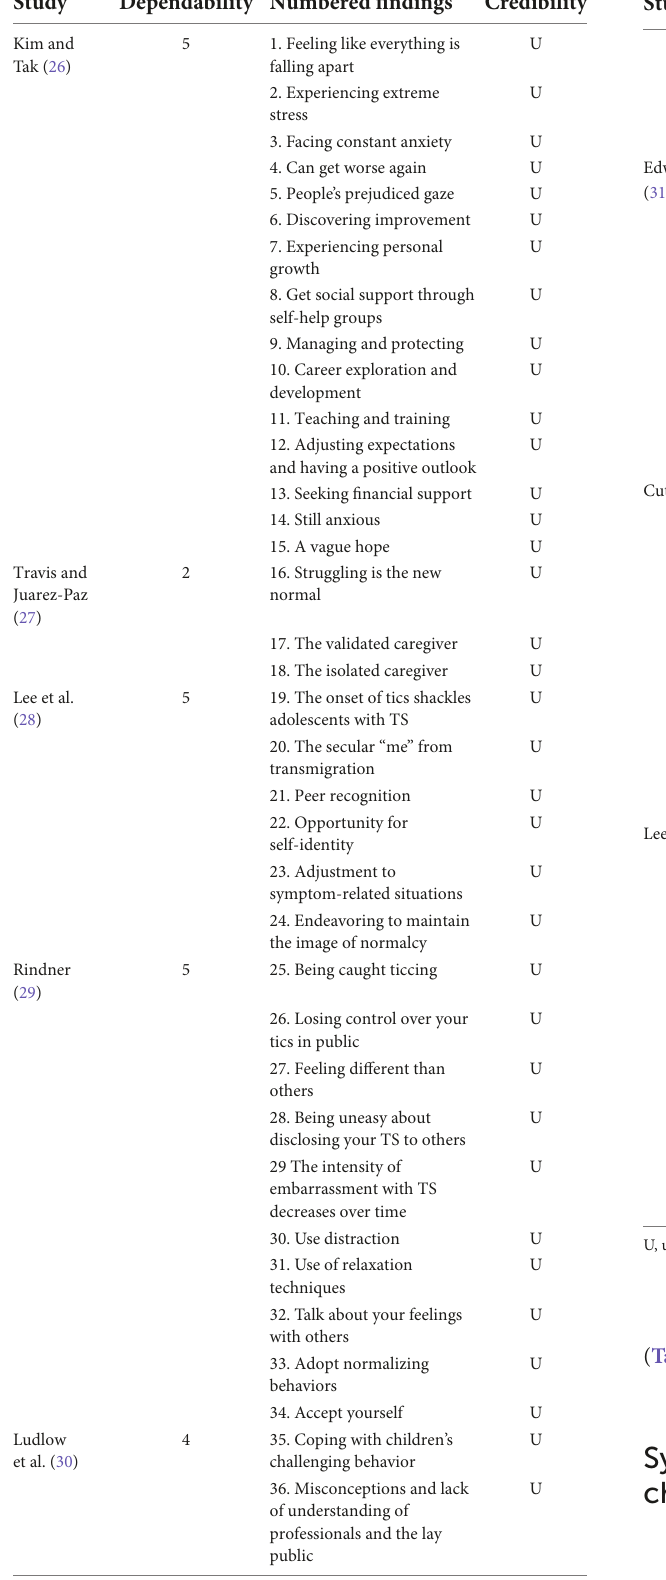
TABLE 2 Findings of the included